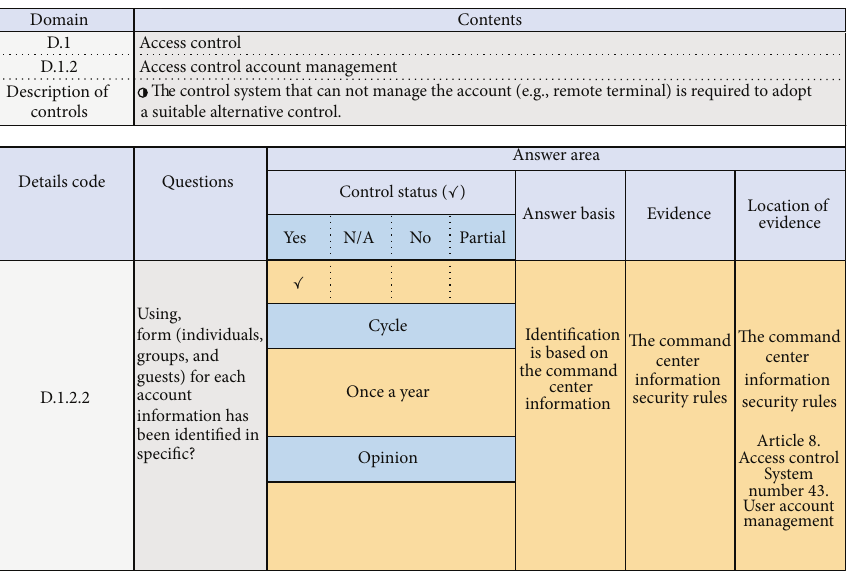
Figure 8: Example of an evaluation sheet.